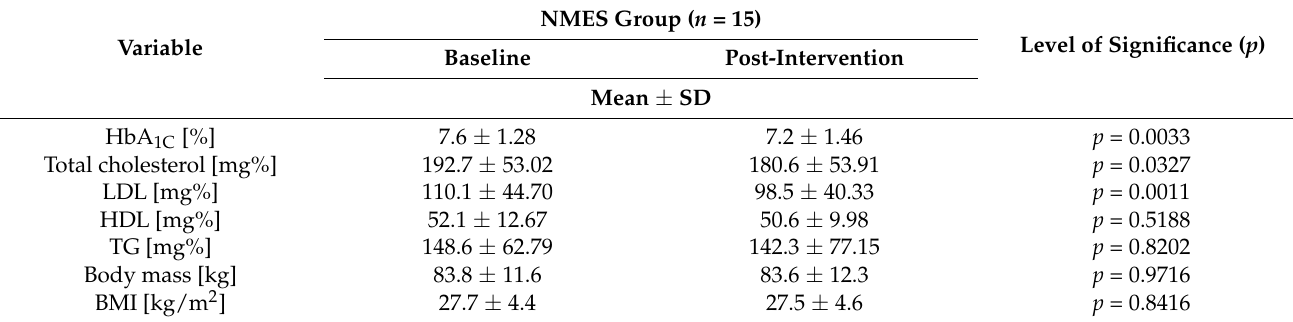
Table 3. Mean metabolic parameters and BMI of patients before and after 12 weeks of intervention ( n = 15).